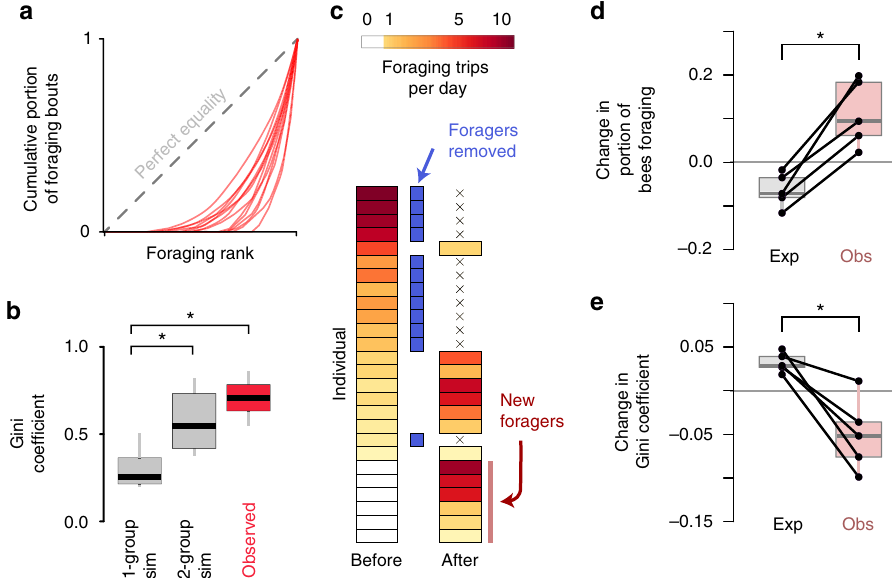
Fig. 2 Foraging activity is regulated at the colony level. a Lorenz curves showing cumulative proportion of all foraging bouts ( y axis) vs. foraging rank ( x axis, sorted by the number of bouts per day performed by each worker) for individual colonies ( n = 14, red lines). b Observed Gini coef fi cients across experimental colonies (red) vs. simulations in which observed foraging activity is randomly distributed across either all bees within colonies (1-group sim, gray) or across foragers and non-foragers (2-group sim, gray). c Foraging activity (mean foraging bouts per day) of individual bees from a single representative colony for the three days before and after an arti fi cial disturbance (forager removal), where 12 foragers were removed from the colony (indicated by blue bars). Data for bees that performed no foraging before or after manipulation ( n = 21) are not shown. d , e Expected (left) vs. observed (right) change in proportion of bees within the colony foraging ( d ) and in the Gini coef fi cient ( e ) after forager removal in fi ve colonies. Black lines connect values from the same colonies before and after treatment. Boxplots show the median and inter-quartile range (IQR), while whiskers depict the data range. Expected values are based on the loss of removed foragers, given the null expectation that all remaining bees would continue their previous activity We quanti fi ed the specialization of workers to colony tasks (DOL ind ) using Gorelick ’ s normalized mutual entropy method 64 , and compared these values to published data for B. impatiens 61 (Fig. 1g, h). Worker specialization measured using data exclusively from during daylight hours was consistent with these published values 61 (Fig. 1g, h). In addition to calculating total